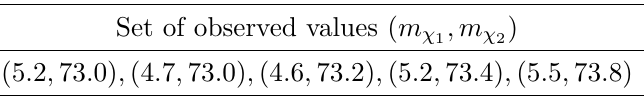
). These were randomly selected ; m (cid:31) 1 2